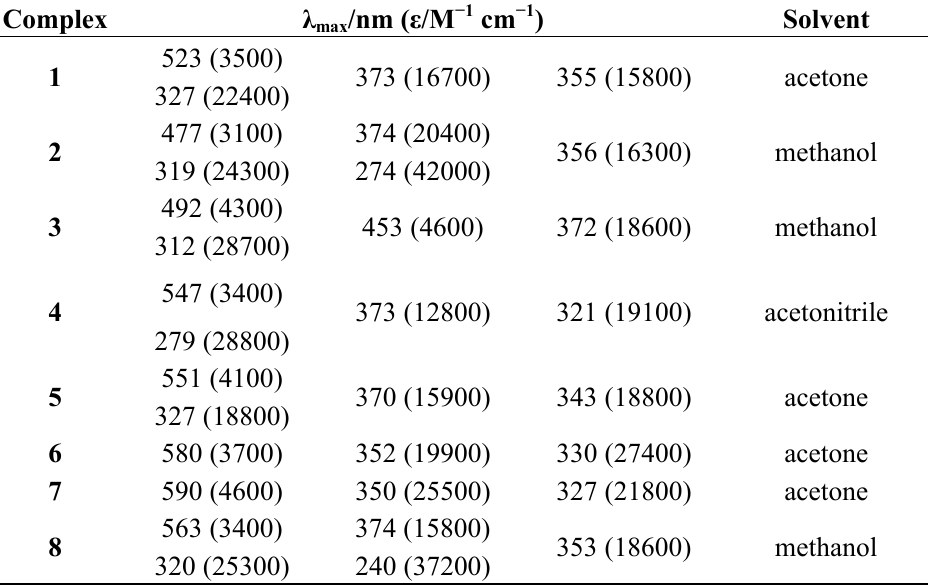
Table 1. Electronic absorption data for complexes 1 – 8 a